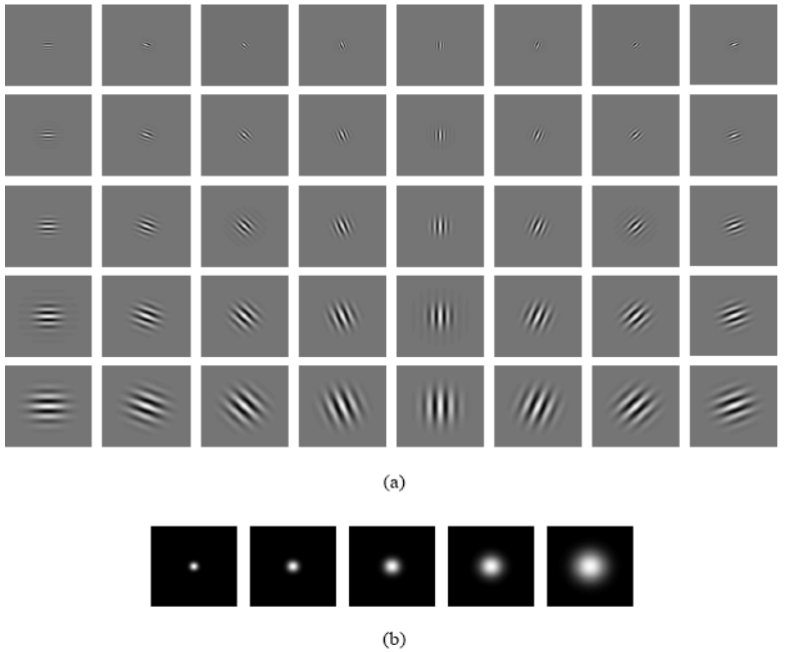
Figure 1. ( a ) The real part of the Gabor wavelet kernels at five scales and eight orientations; ( b ) The magnitude of the Gabor wavelet kernels at five